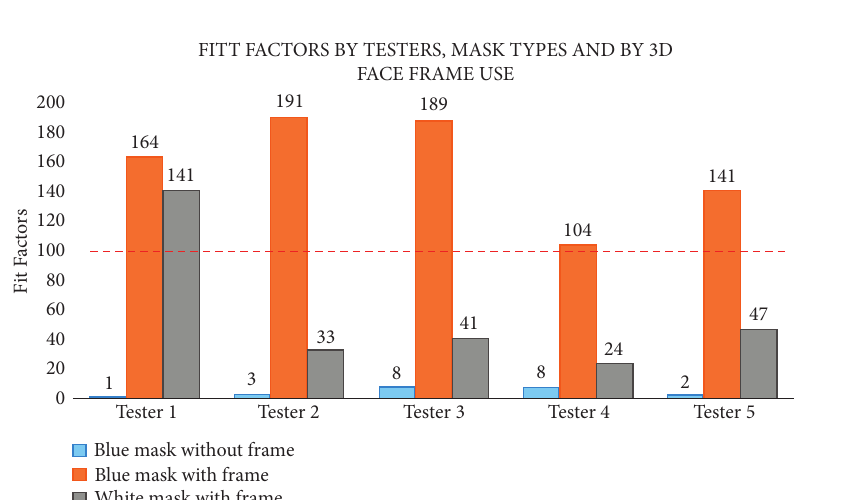
Figure 2: Summarized quantitative fit test results with interpretation. Describe “Head Tilt” results specifically for dentists—(5/5 tests) passed.